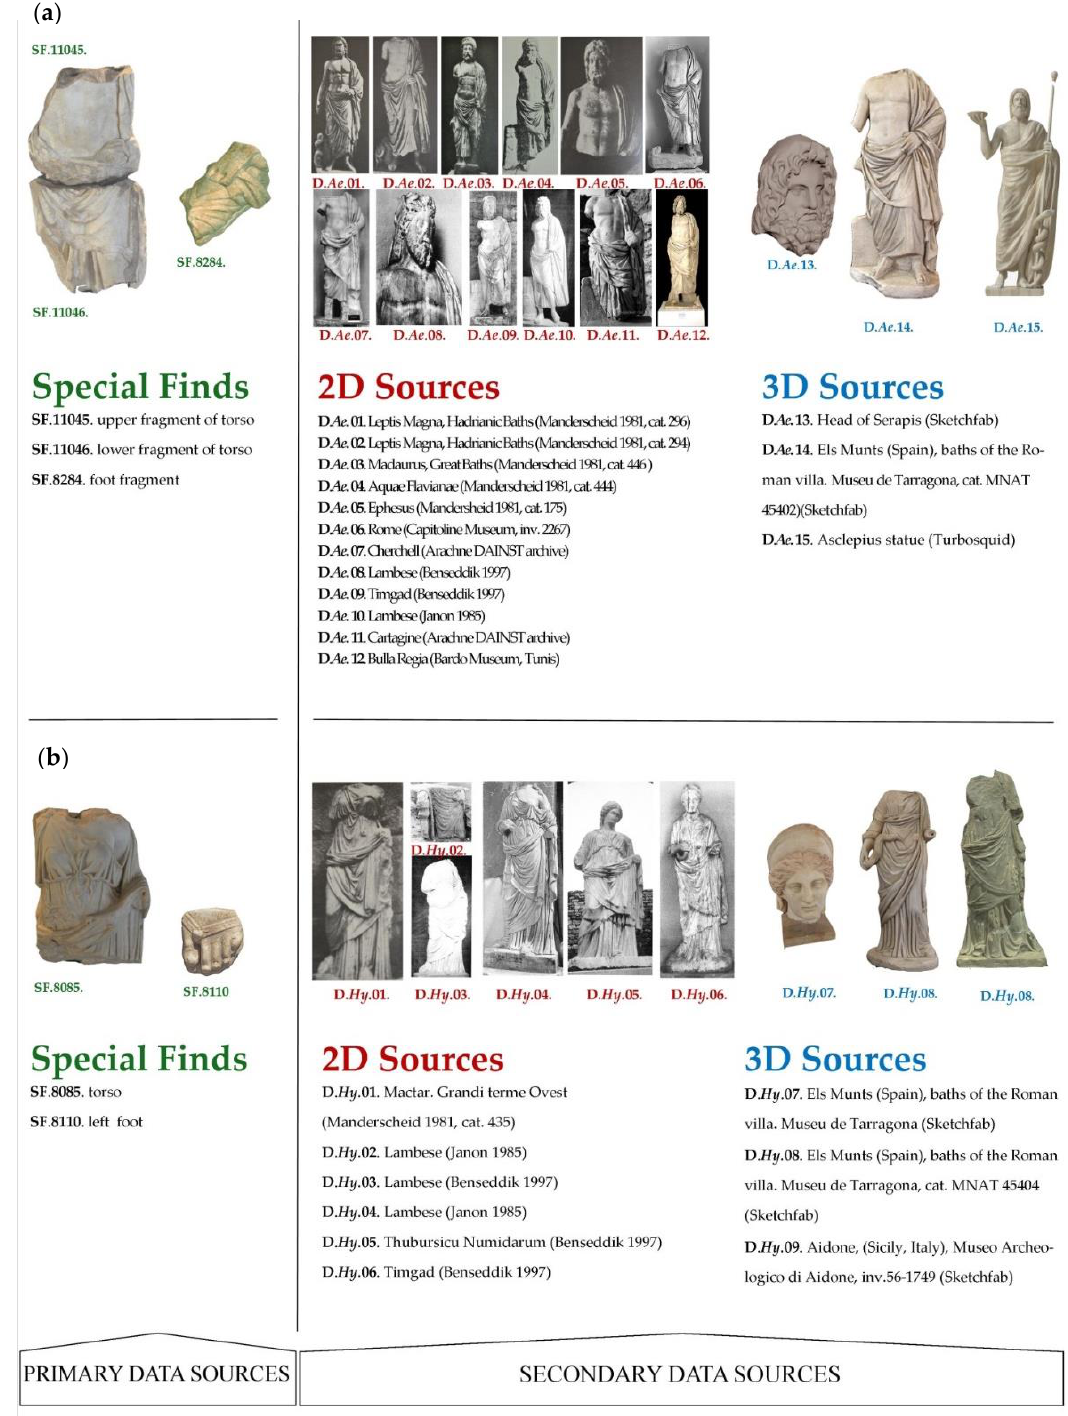
Figure 9. Schemes of input data: collection of primary and secondary data sources for the Aesculapius ( a ) and Hygeia ( b ) statues’ virtual reconstruction. For SFs are provided museum inventory numbers; documents of secondary data sources are instead identified using progressive numbers for both 2D and 3D sources.